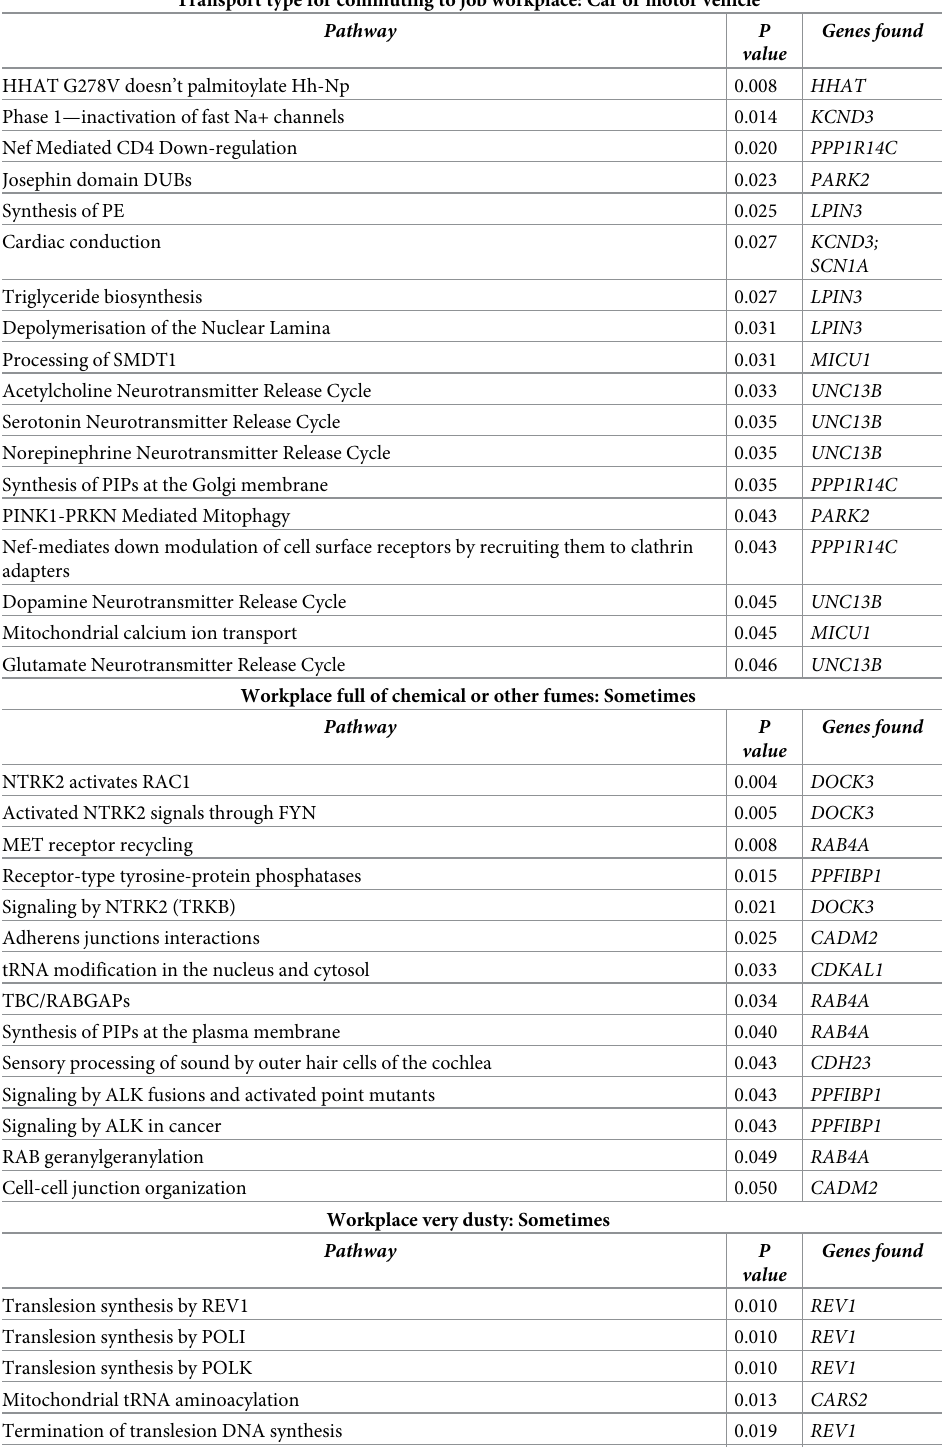
Table 3. The most significant pathways enriched by the genes associated with pollutants. The table shows the path- way name, P value and the genes of our list that are related to that pathway. Transport type for commuting to job workplace: Car or motor